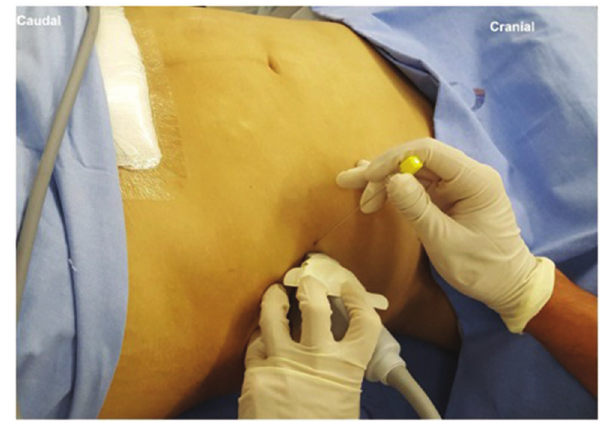
Figure 15 - US probe and needle position for QL blocks types 1 (lateral) and 2